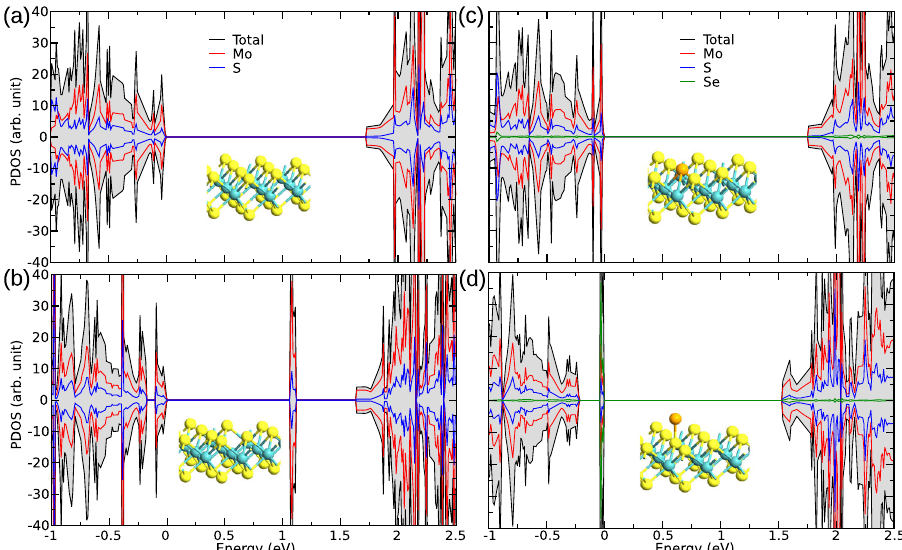
Fig. 2 Calculated projected densities of states. for a pristine material, b a single S vacancy, c a substitutional Se impurity, and d a Se adatom. The Fermi energy is set to 0 eV, and also chosen to coincide with the valence band maximum of the pristine